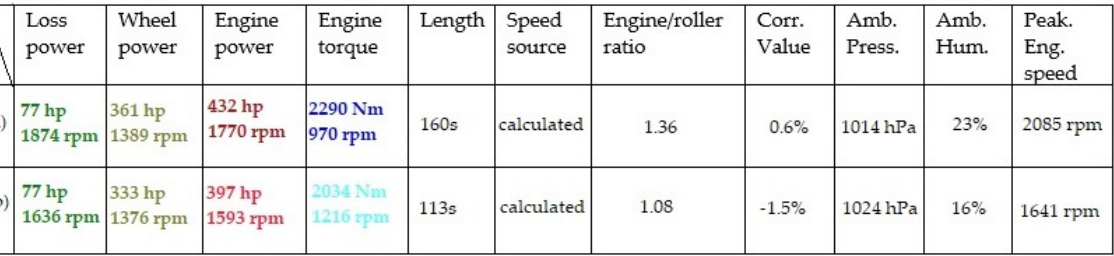
Figure 16. A graph showing the results of external characteristics for the research where: ( a ) attempts were made to reduce the impact of errors, and ( b ) the errors mentioned in this work are combined (authors’ source).